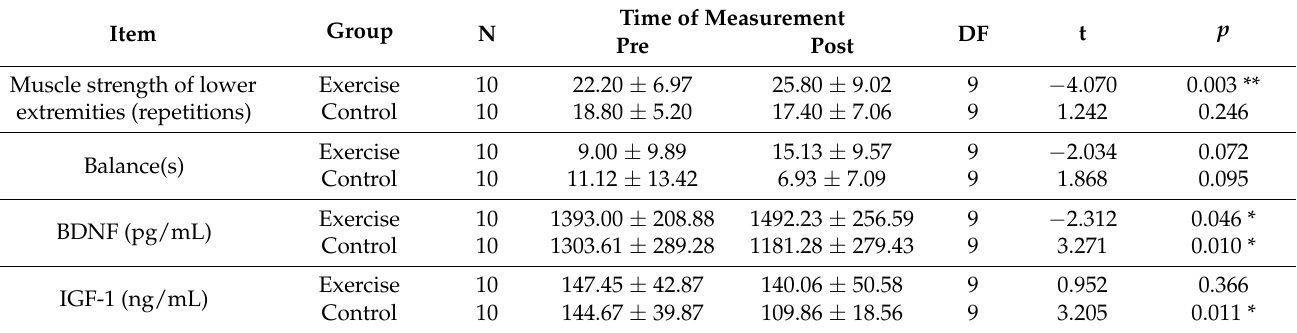
Table 4. Paired t -test